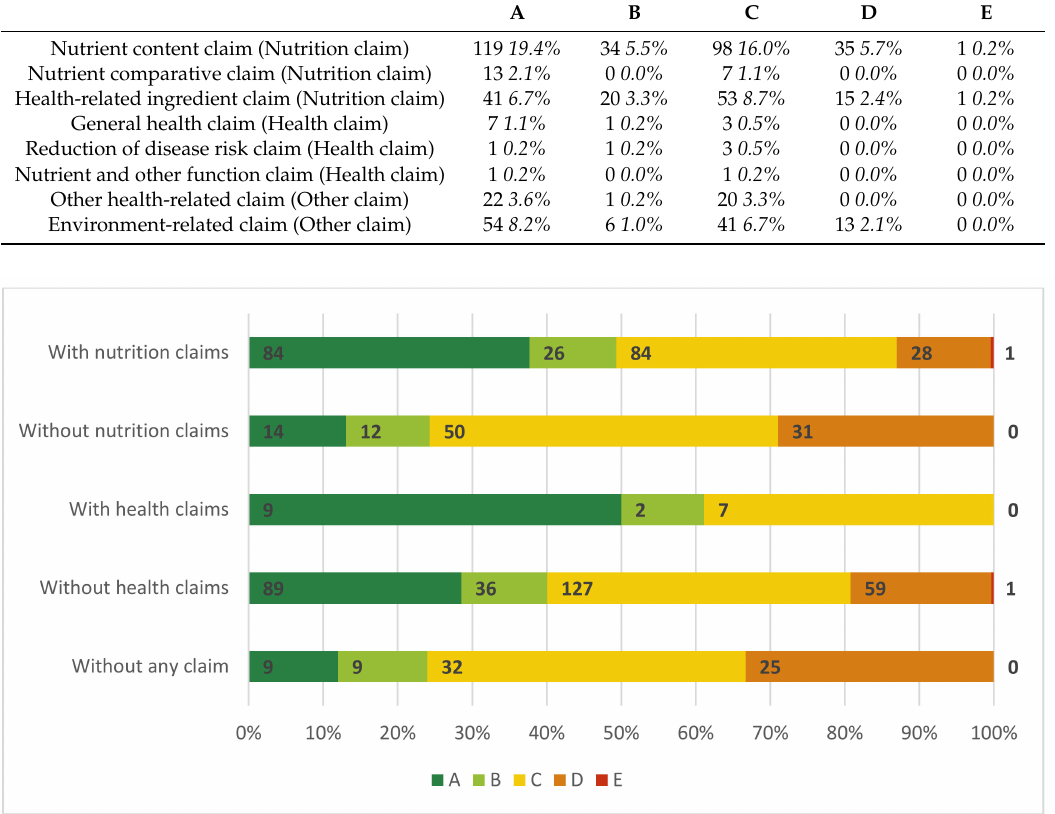
Figure 3. Proportion of breakfast cereals on the Belgian market in 2018 with and without nutrition and / or health claims on the front-of-pack for di ff erent allocated Nutri-Score